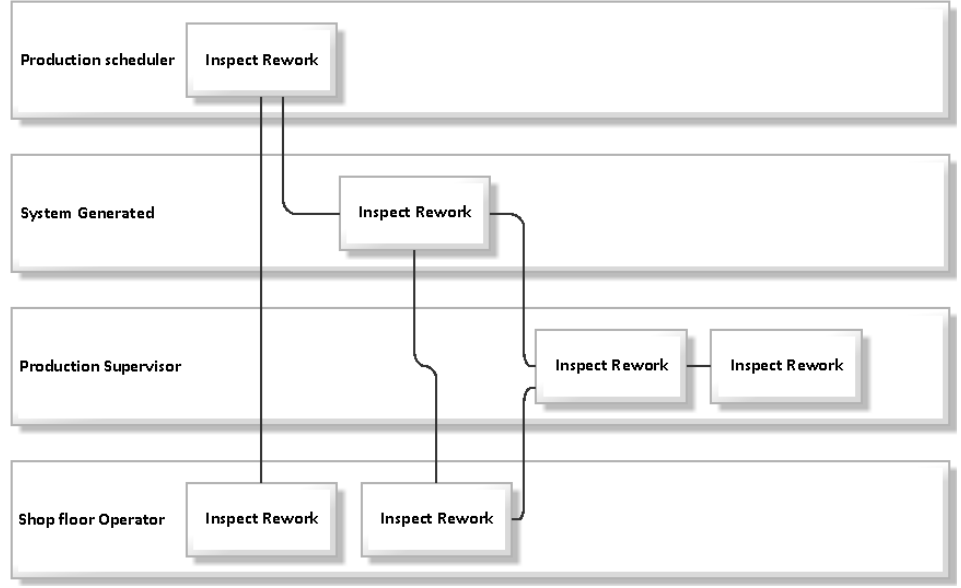
Figure 6. Process of work order scheduling scheme [27].